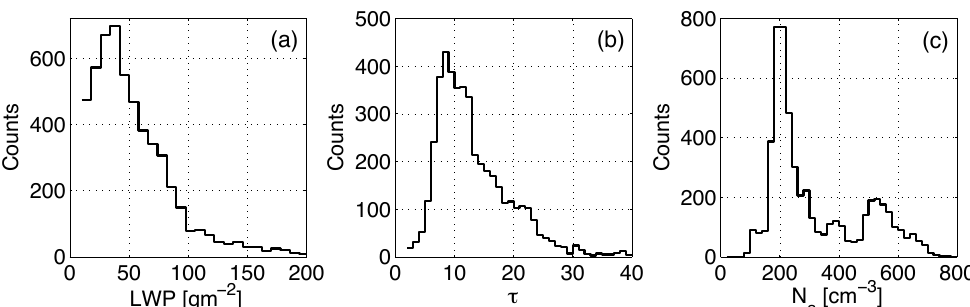
. Histograms 997 a